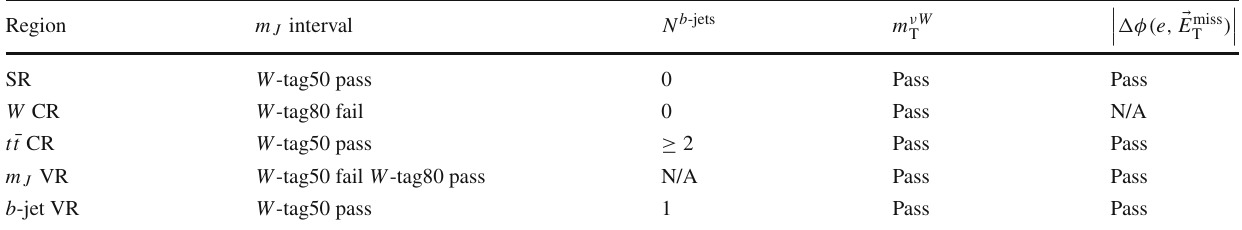
normalization factors with 68% confidence intervals after the background-only fit in the CRs. CRs not defined in the e ν J channel are denoted as “N/A”. The β W normalization factor in the e ν J SR1 is fixed to